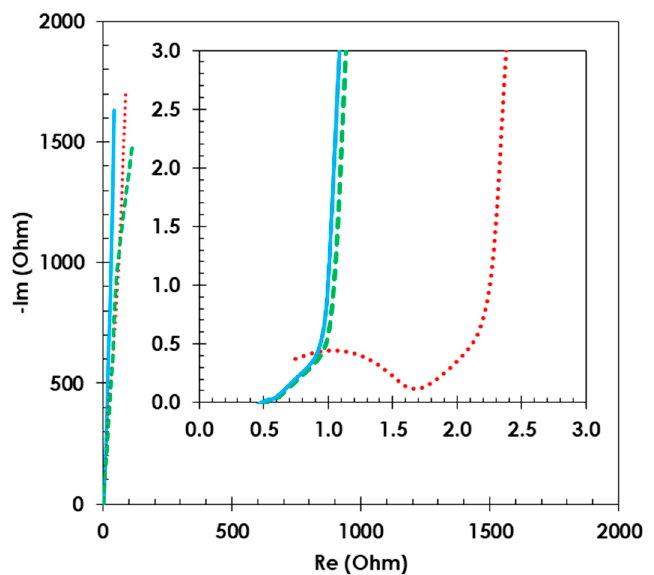
Figure 6. Comparative Nyquist plots for EDLCs with starch as an electrode material binder before ( solid blue line ) and after cycling life studies ( dashed green line ) and with CMC as a binder ( dotted red line ). Composition of electrode material 80 wt. % activated carbon (YP 80F) 10 wt. % carbon black